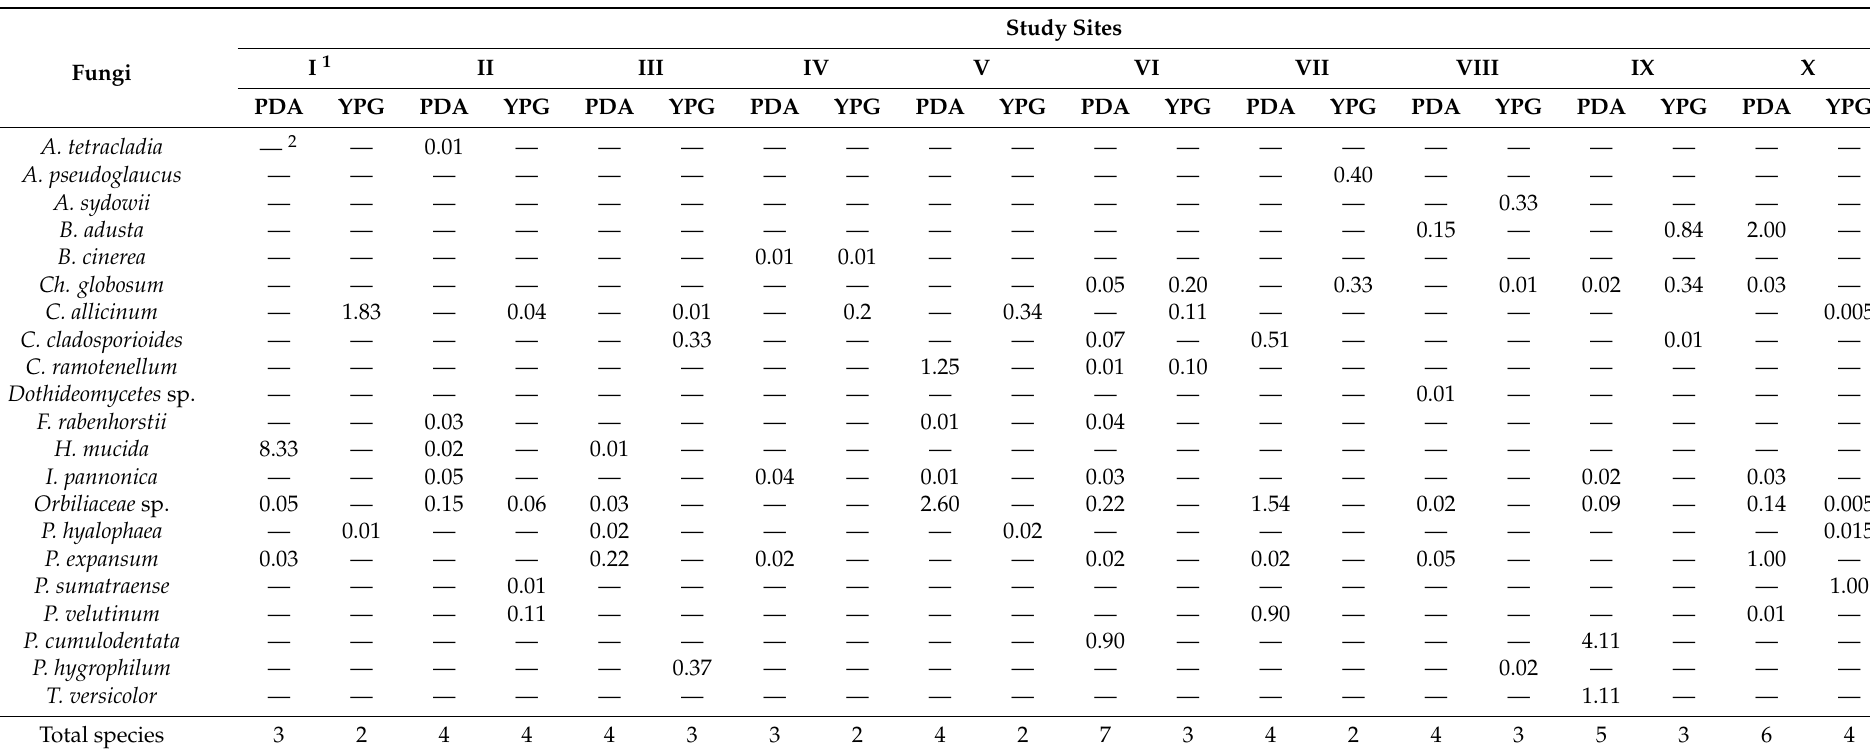
Table A2. Fungi cultured from cryoconite holes (CFU × 10 2 per 1 g) in the Werenskiold Glacier (Spitsbergen) at 24 ◦ C on different media and incubation